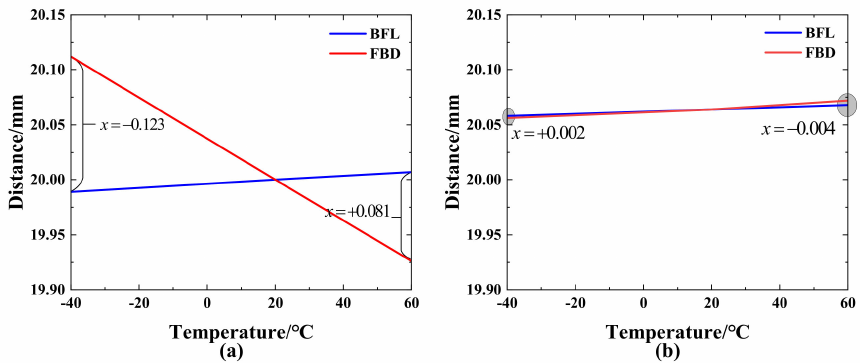
Figure 15. Thermal defocus curves ( a ) initial system ( b ) athermal system.